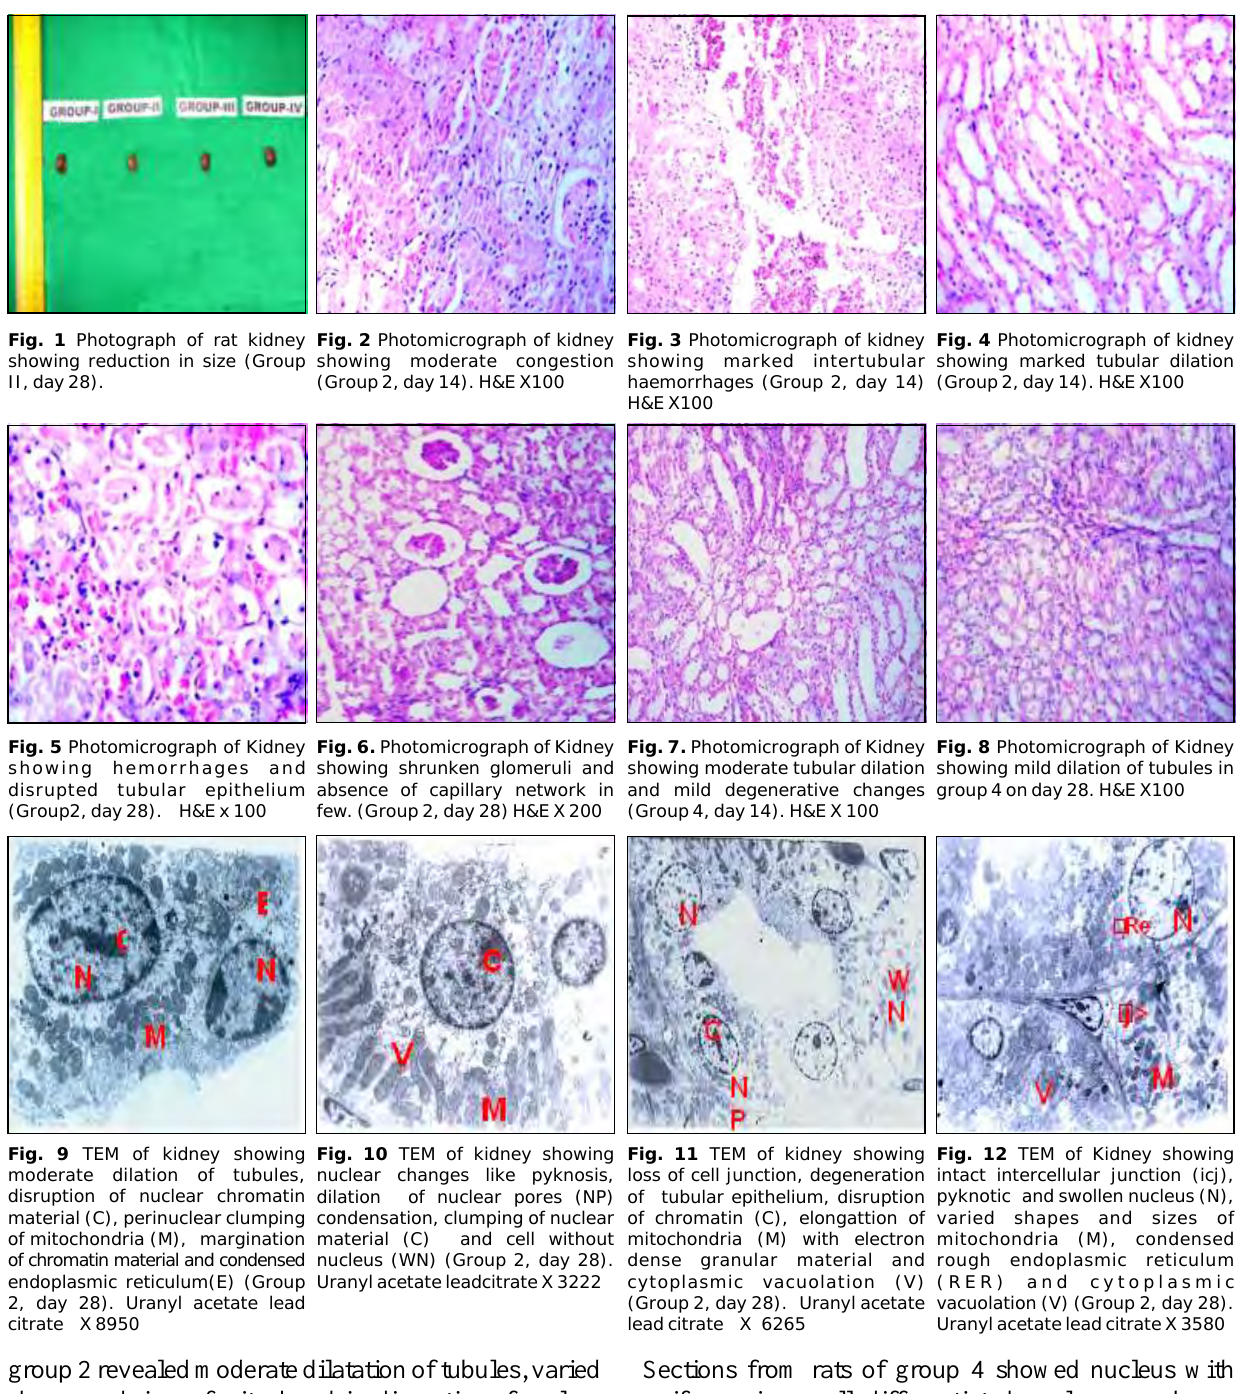
Fig. 10 TEM of kidney showing nuclear changes like pyknosis, dilation of nuclear pores (NP) condensation, clumping of nuclear material (C) and cell without nucleus (WN) (Group 2, day 28). Uranyl acetate leadcitrate X 3222